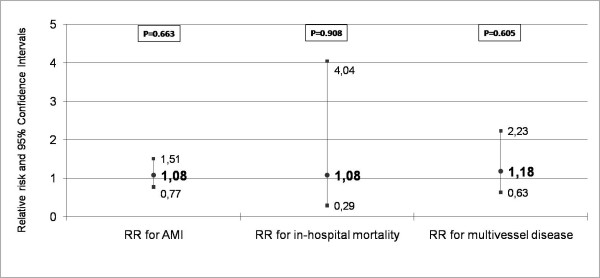
Synopsis of the results of multivariate analyses. The relative risks and the corresponding 95% confidence intervals for AMI, in-hospital mortality and multivessel disease in relation to the presence of the mutated (Asp/Asp) genotype are shown. Detailed description of the variables included in each multivariate analysis is presented in the results section of the manuscript.